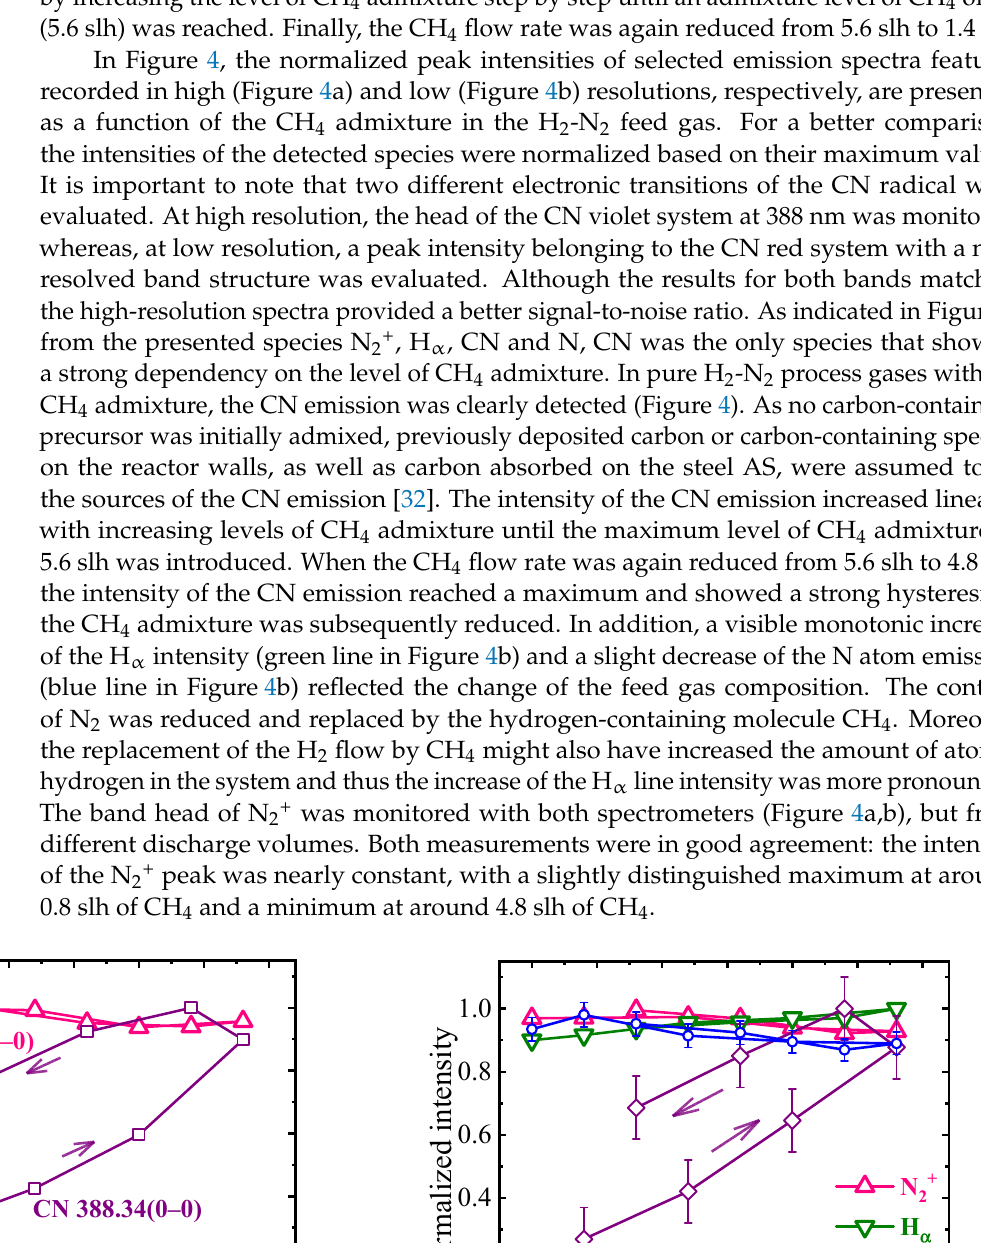
( b ) Figure 5. Concentrations of HCN, C 2 H 2 , CH 4 , and NH 3 measured as functions of the CH 4 flow rate from LAS ( a ) and comparison of normalized signals of CN from high-resolution OES and HCN and C 2 H 2 from LAS ( b ) during ASPNC treatment using a steel AS at H 2 :N 2 = 1:1, p = 3 mbar, T = 460 °C, Φ Total = 80 slh, and P Bias = 1.25 kW. Lines are guides for the eye and arrows indicate the order of measurements.